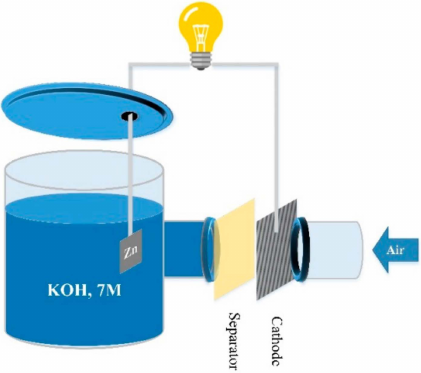
Figure 12. Schematic view of the discharge zinc–air